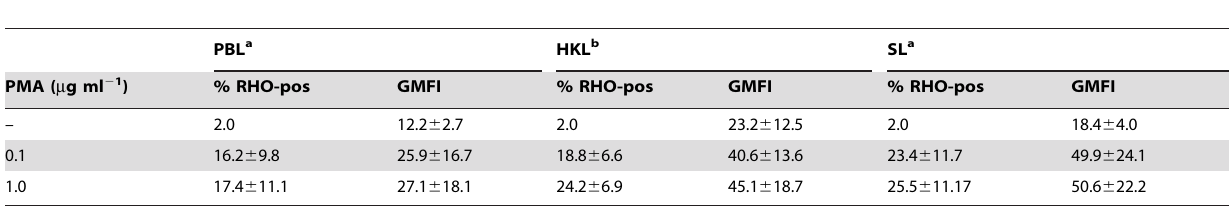
Table 1. The proportions of RHO-positive cells and geometric mean fluorescence intensity (GMFI) of PMA stimulated PBL, HKL and SL from lumpsucker analysed by flow